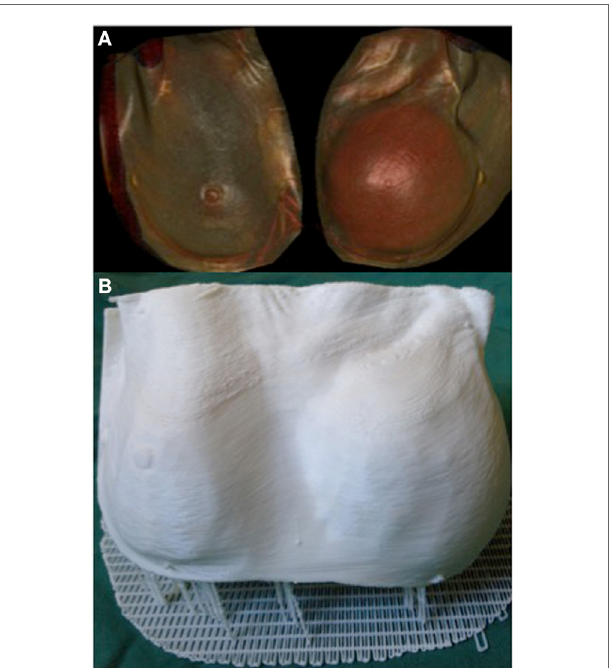
FiGURe 7 | 3D reconstructed CT images of a patient with breast asymmetry post-mastectomy (A) and the 3D printed breast model of the same patient (B) . Reproduced with permission from Breast Cancer Research and Treatment (108).